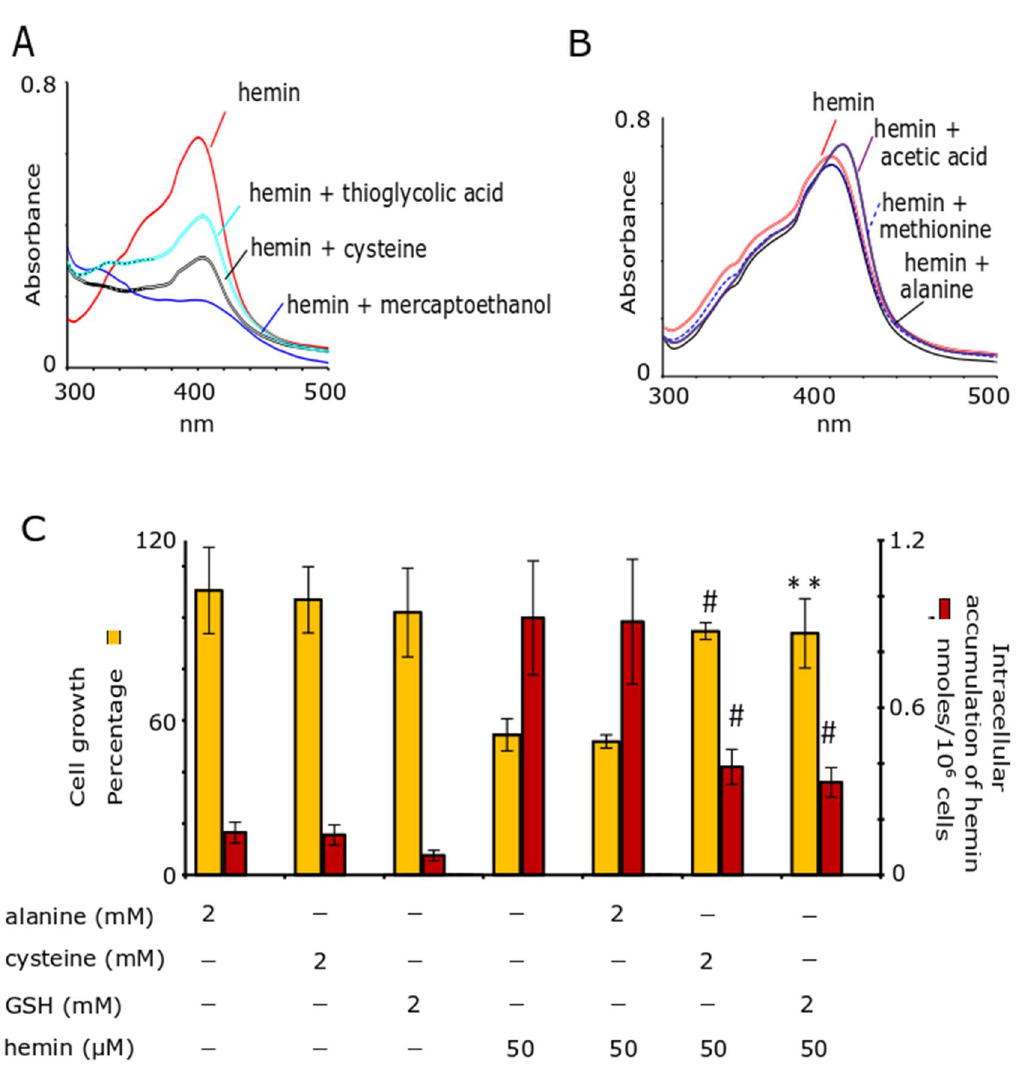
Figure 3. The effect of different thiols (GSH, cysteine, thioglycolic acid, and mercaptoethanol) on the spectrum of hemin, as well as of GSH and cysteine, on cell growth and the intracellular content in hemin. ( A , B ) Hemin (50 µ M) was incubated with each one of the thiols and/or with alanine or acetic acid or methionine (2 mM) in a cell culture medium at 37 ◦ C for 12 h. Spectrophotometric changes of hemin were then recorded. The spectrum of hemin in the presence of GSH is presented in the Supplementary Materials [31] and is also presented here, for reasons of clarity. ( C ) K562 cells were incubated simultaneously with hemin (50 µ M) and with alanine, cysteine, and/or GSH (2 mM) and then the intracellular content of cells with hemin (at 12 h) and cell growth (at 24 h) were determined. Cell growth is presented relative to the growth of untreated cells (100%). Cells incubated with only hemin and/or alanine, cysteine, or GSH served as the experimental controls. Statistical differences are shown between cells treated with hemin only and those treated simultaneously with hemin and GSH or cysteine. p values < 0.01 (**) and 0.001